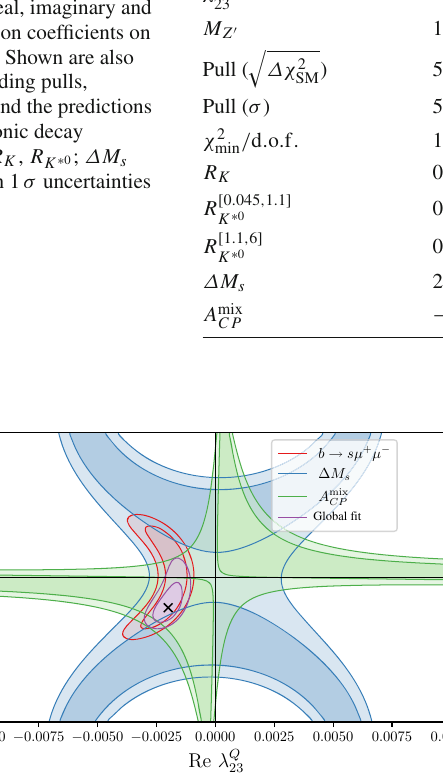
Fig. 4 Fit on Z (cid:2) parameter space in the λ Q fit Z (cid:2) mass M Z (cid:2) = 1 . 08TeV (see